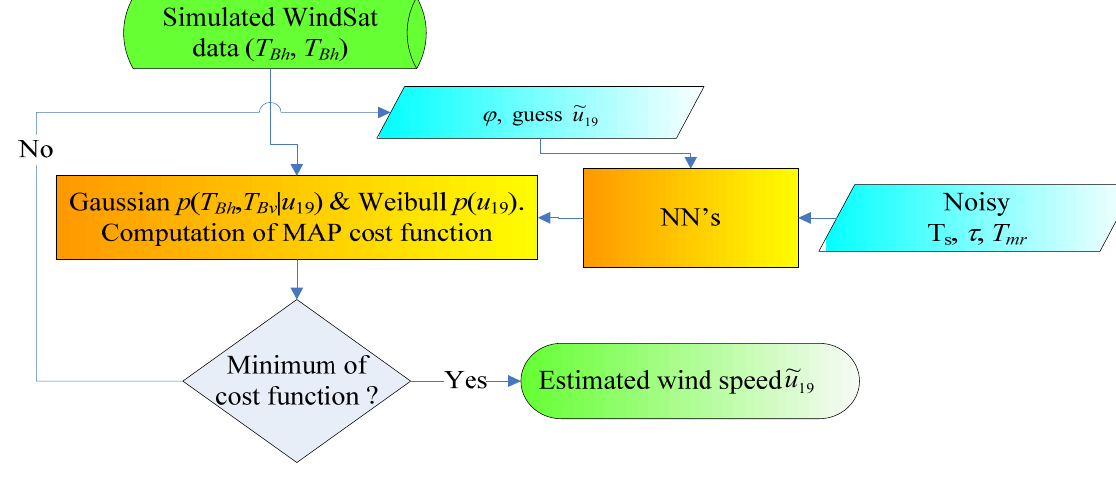
Figure 3 . Block diagram of the MAP wind speed estimator. Note that φ is equal to 180° (first step of the wind vector retrieval procedure), or to the estimated azimuth angle  ~ (third